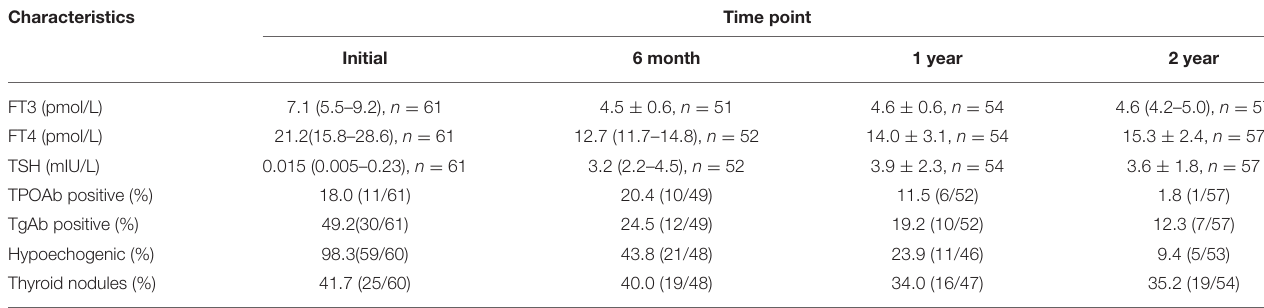
TABLE 3 | Variable changes during follow-up.